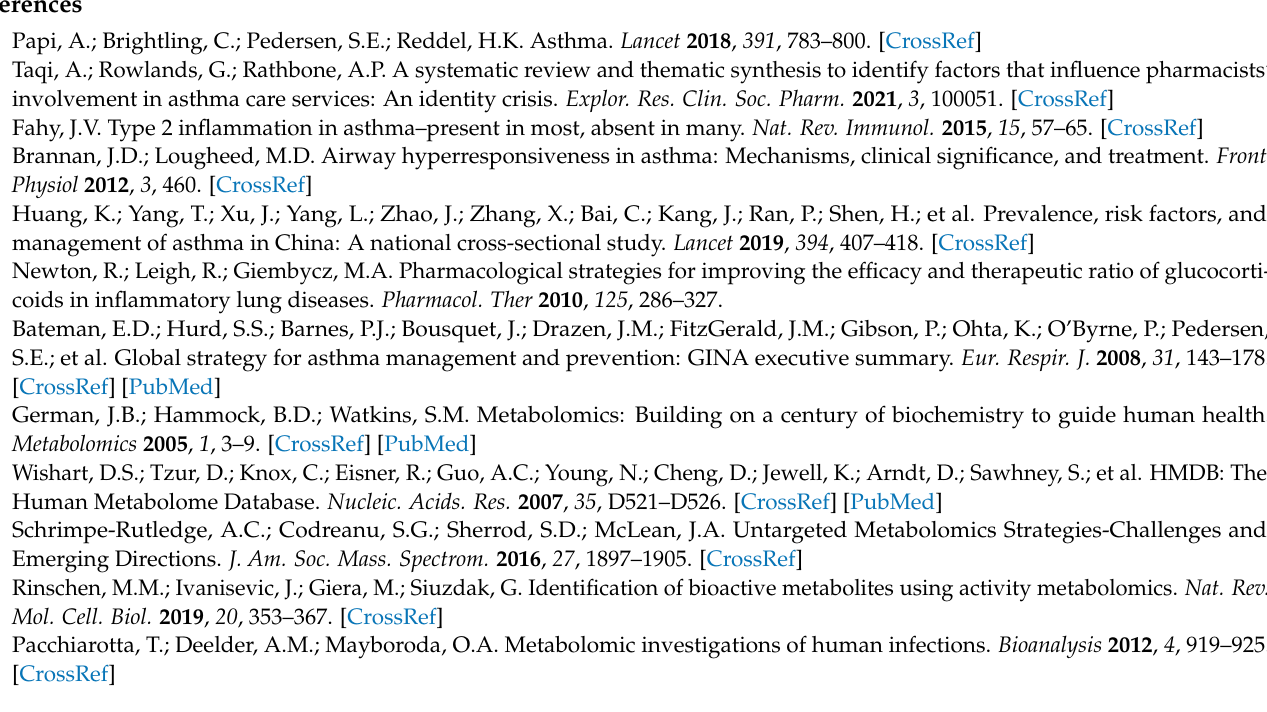
Figure S3: (A) The top 10 enriched GO-BP terms. (B) Differential expression of immune cells in two groups. * p < 0.05, ** p < 0.01; Table S1: The samples of GSE76262 were respectively clustered in the disease condition and NMF typing. Table S2: Clustering of samples in healthy and diseased groups in GSE4302. Table S3: All DEGs of